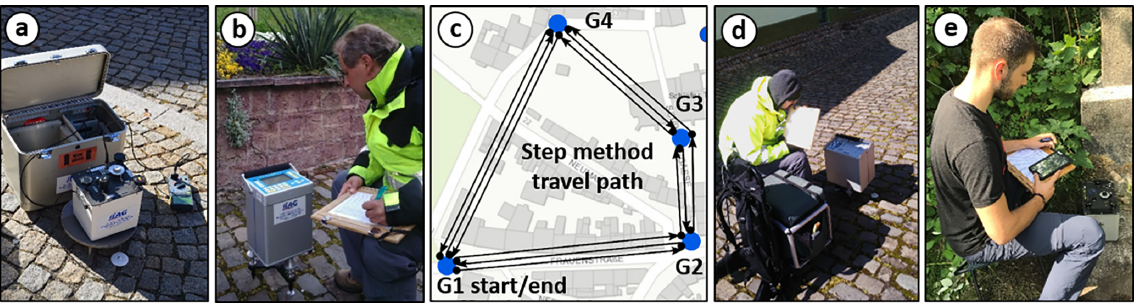
Figure 5. Overview of the gravity meters and the method that was used in this study. The accuracies (acc) were obtained from least squares adjustments per campaign and are valid for the single measurement of a gravity difference. (a) LaCoste&Romberg G-Type (acc: ≤ 10µGal). (b) Scintrex CG5 (acc: ≤ 5µGal). (c) Travel path for the application of the step method – four points in a polygon mean 13 measurements. (d) Scintrex CG3 (acc: ≤ 8µGal). (e) ZLS Burris Gravity Meter (acc: ≤